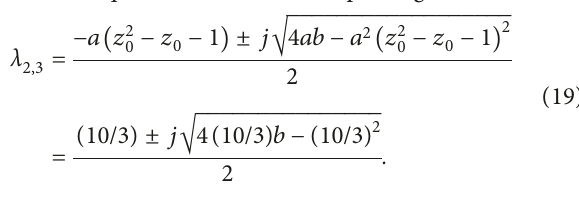
LAB. Figure 6(a) is the α -order differentiator block design.